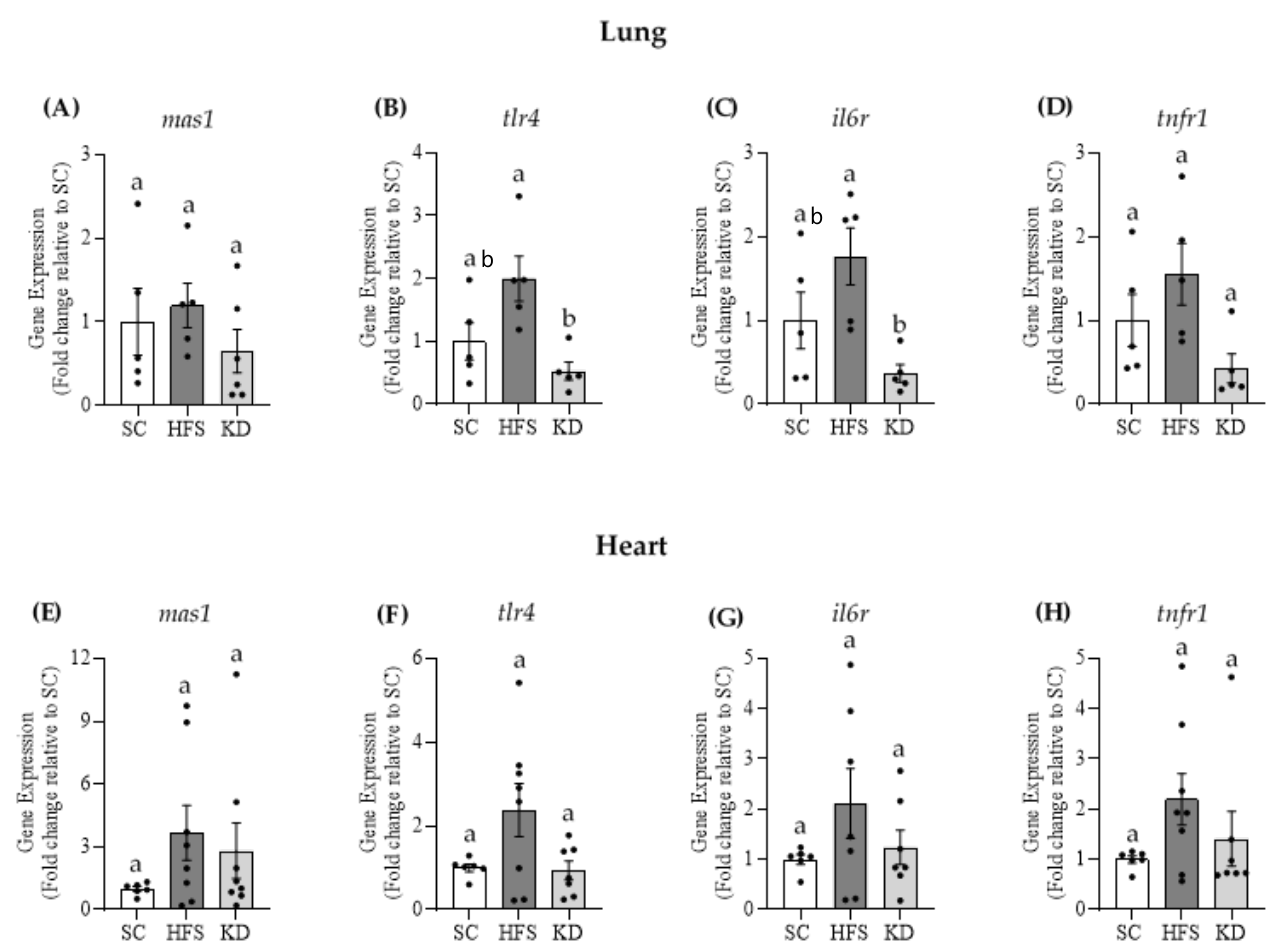
Figure 4. The KD does not affect mas1 gene expression in lung ( A ) or heart ( E ) tissues. Interestingly, KD-feeding significantly reduces toll-like receptor 4 ( tlr4 ) and interleukin-6 receptor ( il6r ) gene expression in pulmonary tissues ( B , C , respectively), when compared to the HFS diet. The KD also reduced tumour necrosis factor receptor 1 ( tnfr1 ) gene expression in lungs ( D ), though this was not statistically significant. Tlr4, il6r and tnfr1 were not significantly altered by diet in cardiac tissues ( F – H , respectively). Statistical significance is denoted by different letters p < 0.05. Bars represent mean ± SEM. One-way ANOVA, n = 5 – 8.